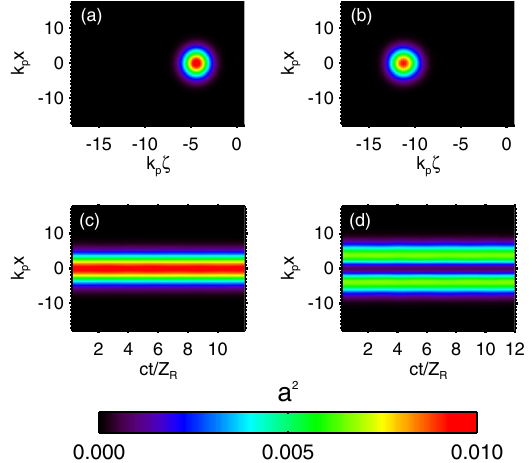
FIG. 1. Normalized intensity profile as a function of longitu- ð z (cid:3) ct Þ and transverse k (cid:4) ¼ k x coordinates, for the dinal k p p p fundamental Gaussian mode propagating in a matched plasma ¼ 0 : 22 and (b) ct=Z ¼ 10 (slippage due channel, at (a) ct=Z R R < c is visible); (c) corresponding transverse intensity to v g profile, integrated over the longitudinal dimension, as a function of propagation distance. (d) Integrated transverse intensity pro- file of the first-order Hermite-Gaussian mode propagating in the same plasma